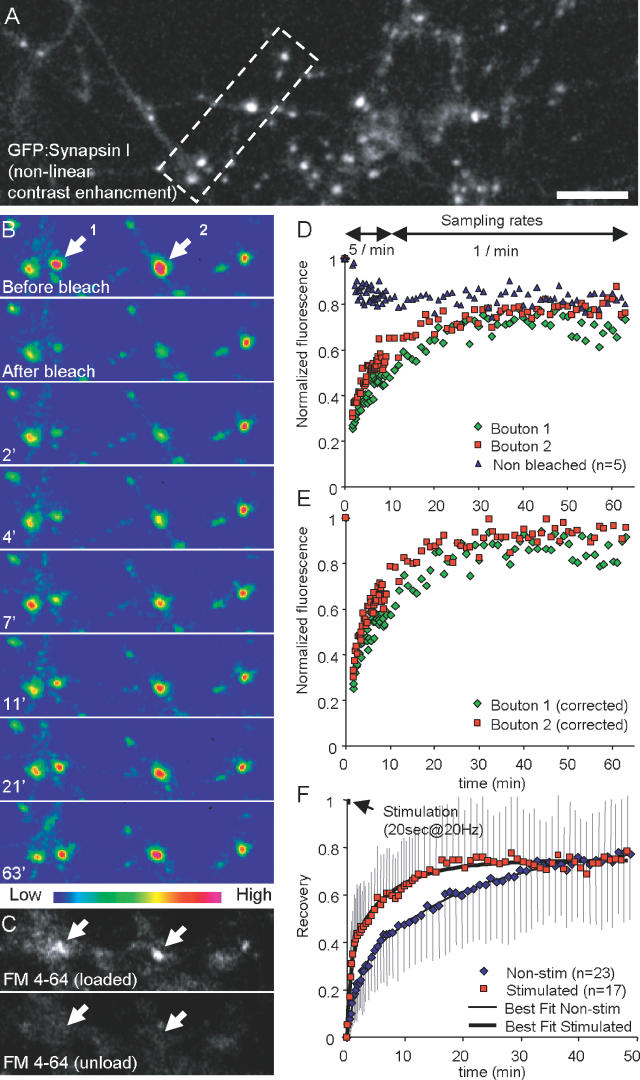
Loss and Reincorporation Rates of GFP:Synapsin I at Individual Synaptic Boutons(A) Axons of neurons expressing GFP:Synapsin I. Presynaptic boutons appear as bright puncta along faintly fluorescent axons. The contrast was enhanced nonlinearly in this figure to emphasize axonal fluorescence and demonstrate that the boutons photobleached here did not reside along the same axonal segment. Bar, 10 μm.(B) Two boutons (arrows) were selectively photobleached by high-intensity laser light, reducing their fluorescence to approximately 30% of their nominal values. Fluorescence recovery at these sites was then followed by time-lapse imaging, initially at 20-s intervals and later at 1-min intervals. GFP:Synapsin I fluorescence levels shown in false color according to color scale near bottom.(C) At the end of the experiment, presynaptic boutons were labeled (loaded) with FM4–64 by field stimulation (30sec@10hz) followed by unloading (120sec@10hz) to verify the functionality of the photobleached boutons (bottom panels). Note that both photobleached boutons exhibited a capacity for evoked endocytosis and exocytosis of FM4–64. Only boutons that exhibited such a capacity were included in our analysis. Same region as that enclosed in rectangle in (A). Times given in minutes.(D) Fluorescence recovery time course for photobleached boutons in (A) as well as the mean fluorescence of five nonphotobleached boutons in the same field. Note the gradual reduction of fluorescence in these boutons and its dependence on the sampling rate, indicating that illumination applied during ongoing imaging induces some photobleaching that should be corrected for.(E) Fluorescence recovery time course after correcting for ongoing photobleaching.(F) Loss and reincorporation of GFP:Synapsin I molecules at synapses are accelerated by synaptic activity. Neurons were stimulated for 20 s at 20 Hz immediately after collecting the first postbleach images. Despite the brief duration of this stimulation episode, fluorescence recovery was accelerated significantly in comparison to recovery in matched, nonstimulated preparations. Data shown are mean ± standard deviation for all photobleached boutons after normalization as described in Materials and Methods. One-sided error bars only are shown in sake of clarity. The data were fit to a model assuming two pools with different recovery kinetics as described in the text. All experiments were performed in the presence of CNQX (10 μM) and AP-5 (50 μM) to minimize spontaneous activity.